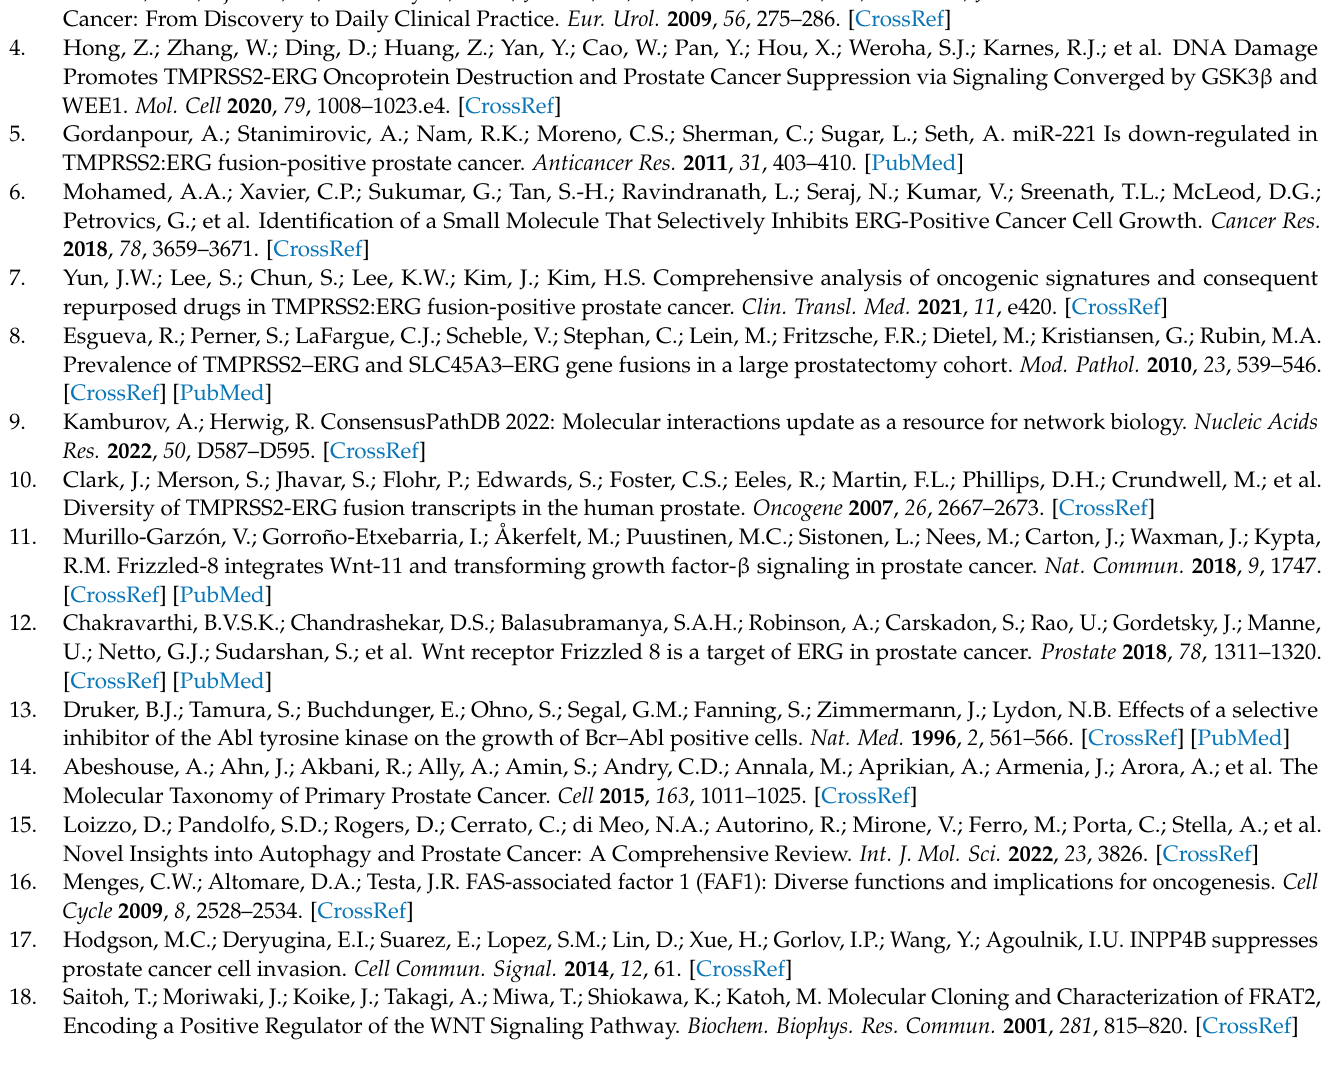
patient. Table S3: Gene list with correlation efficiency for selected pathways though S:E fusion ORA. Table S4: Gene list with correlation efficiency for selected pathways though T:E fusion